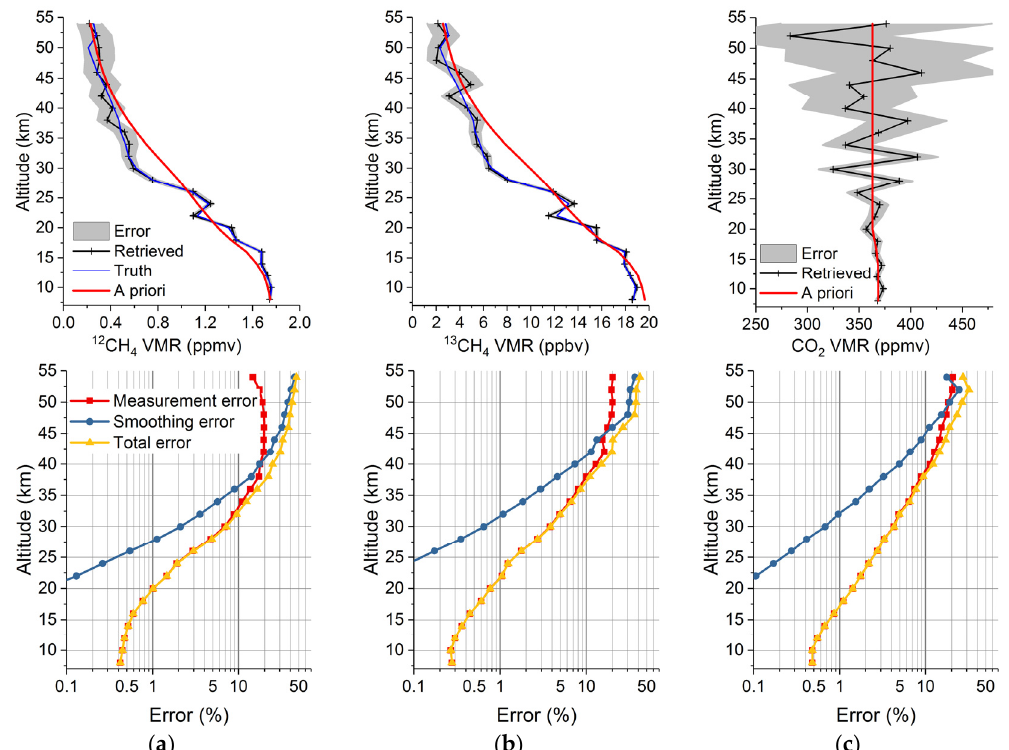
Figure 8. Single observation OSS retrieval outcomes: ( a ) 12 CH 4 retrieved from the SWIR LHR in the top panel and associated retrieval random errors in the bottom panel; ( b ) 13 CH 4 retrieved from HIROS; and ( c ) CO 2 retrieved from HIROS (first guess and a priori identical to “truth” in this case).